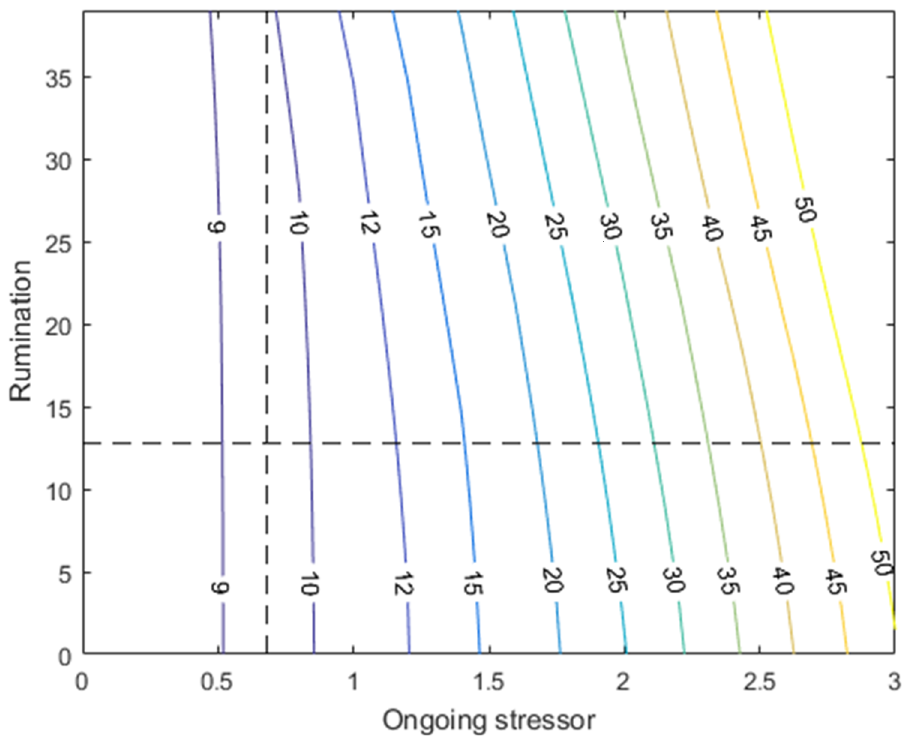
Fig 5. Depressive symptoms at time 120 by rumination and ongoing stressors for a simulated girl whose prior stressors and depressive symptoms are set at the mean.